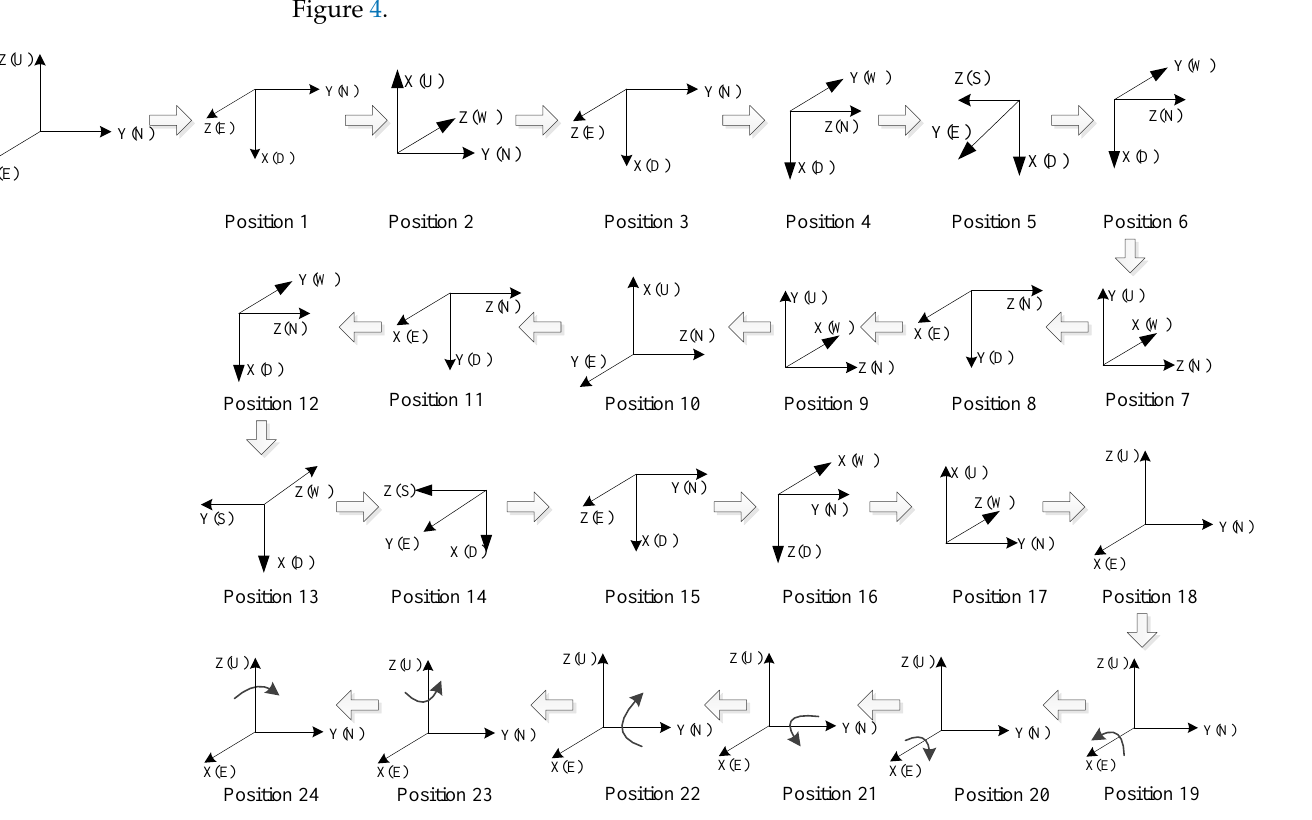
Figure 4. The 24 positions of the calibration .